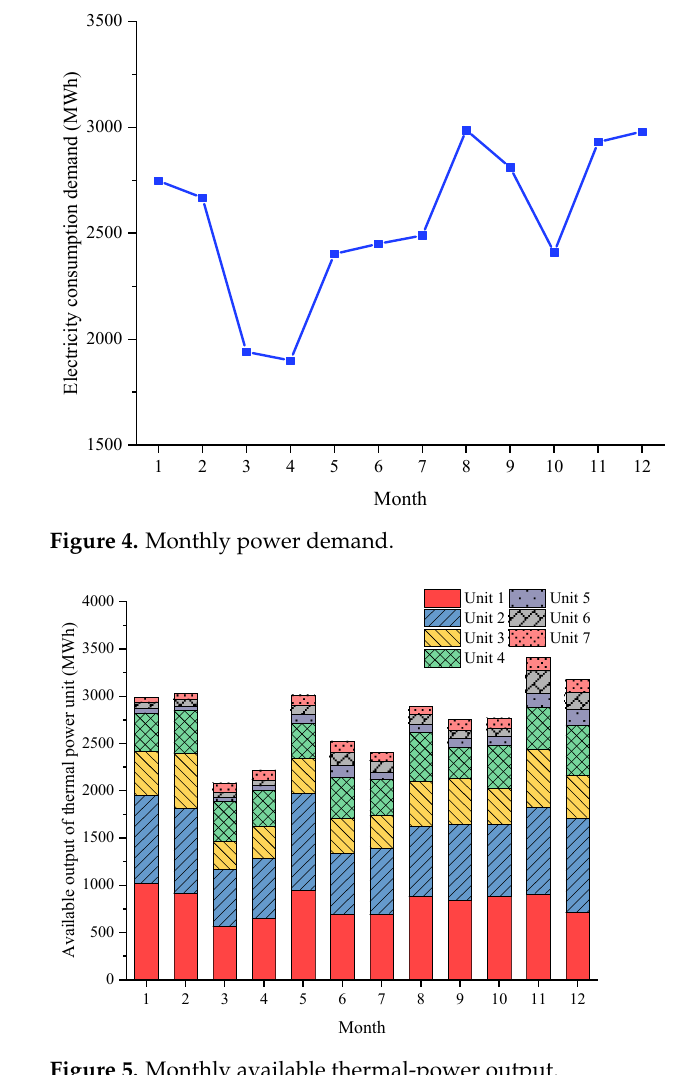
Figure 6. Monthly price in the electricity market. Figure 7. Monthly available photovoltaic-power output.